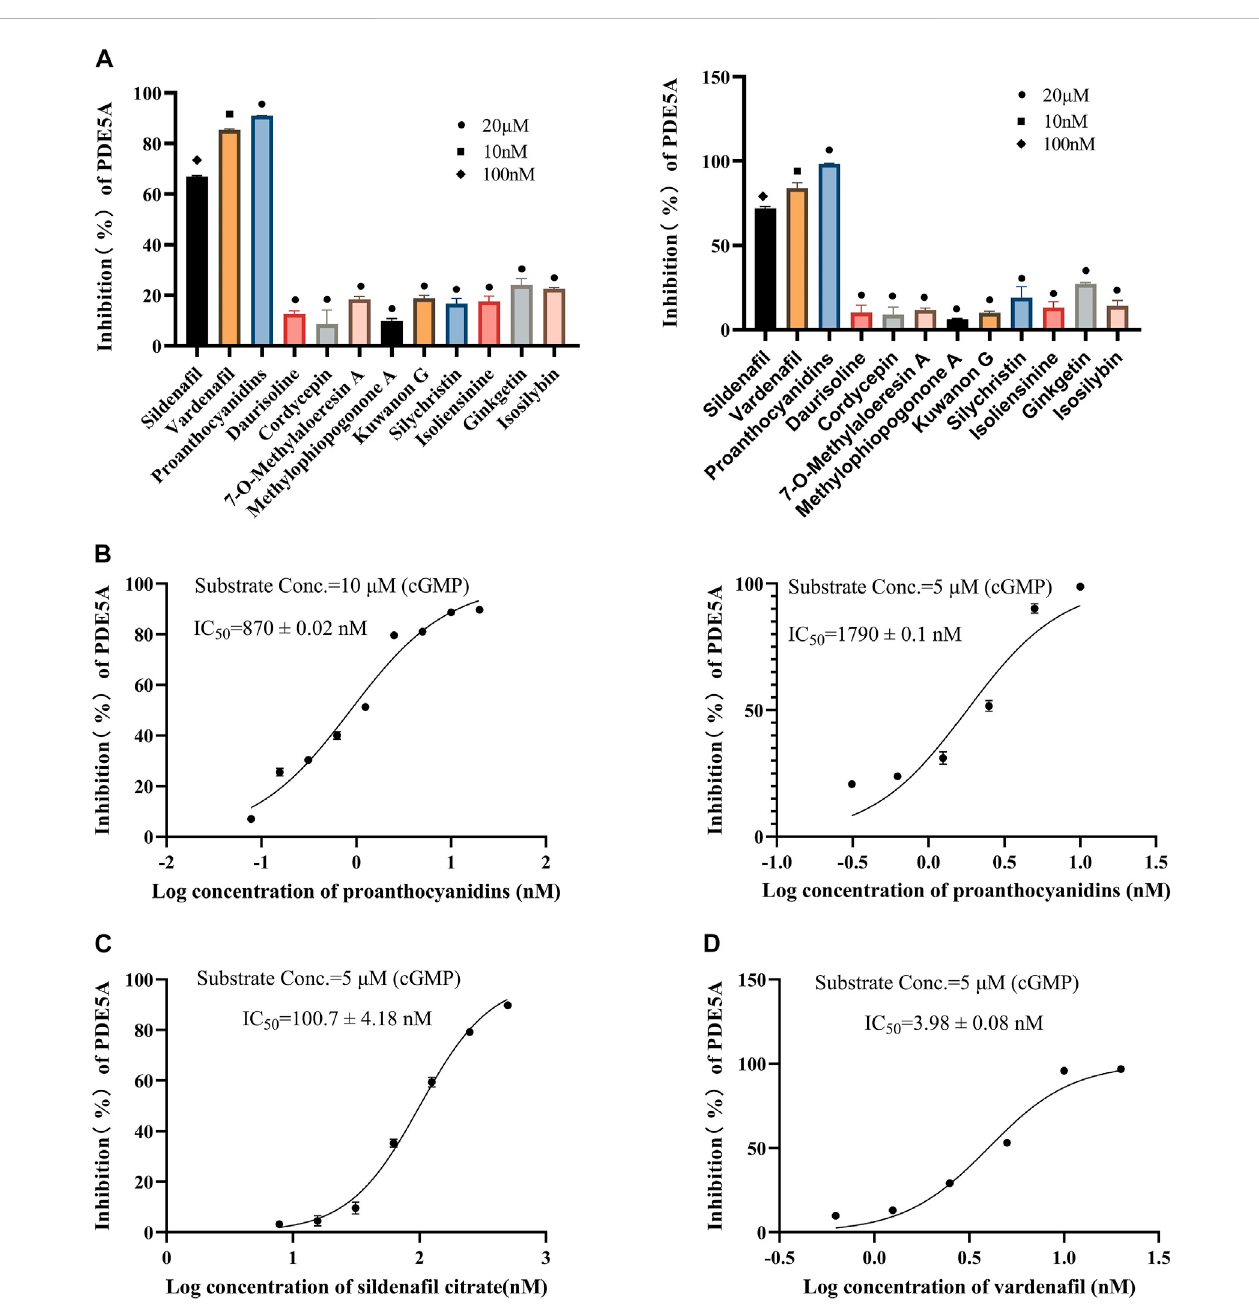
Inhibitory activity of 10 compounds for PDE5A based on the LC/MS-based method and luorescent-labeled substrate-based method. (A) Inhibitory activity of 10 compounds for PDE5A at 20 μ M, and sildena fi l and vardena fi l were set to 100 nM and 10 nM, respectively (left: LC/MS-based method; right: luorescent-labeled substrate-based method). (B) Inhibition curve of proanthocyanidins. Left: LC/MS-based method; right: luorescent-labeled substrate- based method. (C, D) Inhibition curves of sildena fi l, vardena fi l (luorescent-labeled substrate-based